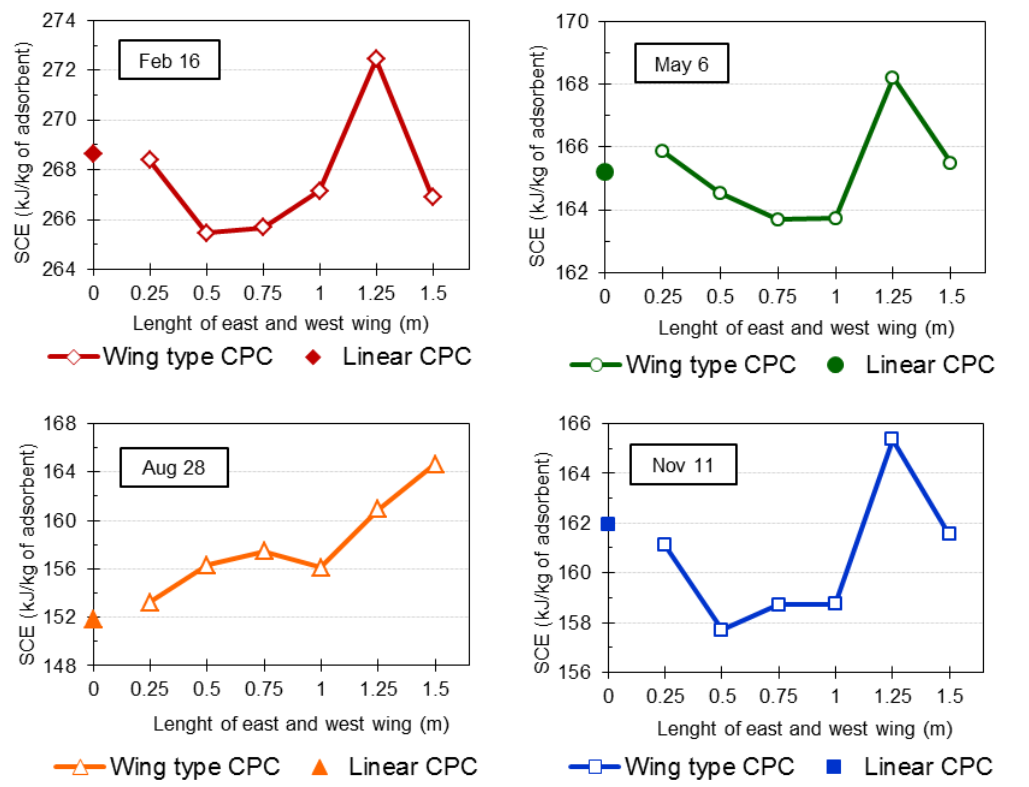
Figure 11. Effect of length of wings in season of year and performance comparison with linear CPC.